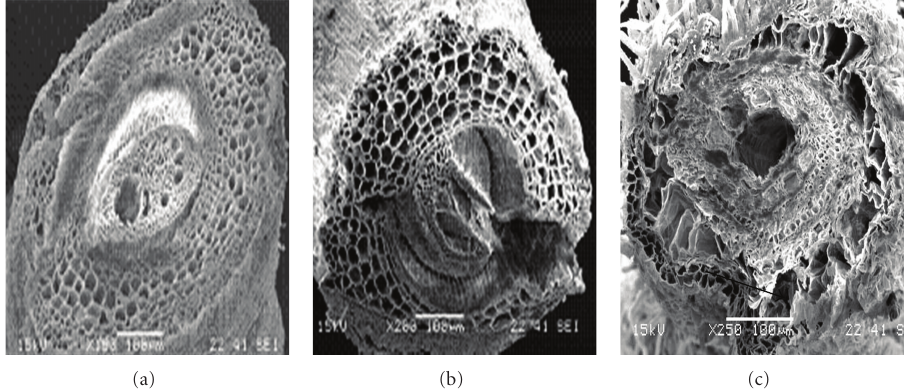
Figure 5: Scanning electron microscopy photographs showing root cortical tissue of Zoysia matrella under (a) 0, (b) 24, and (c) 48dS m − 1 .